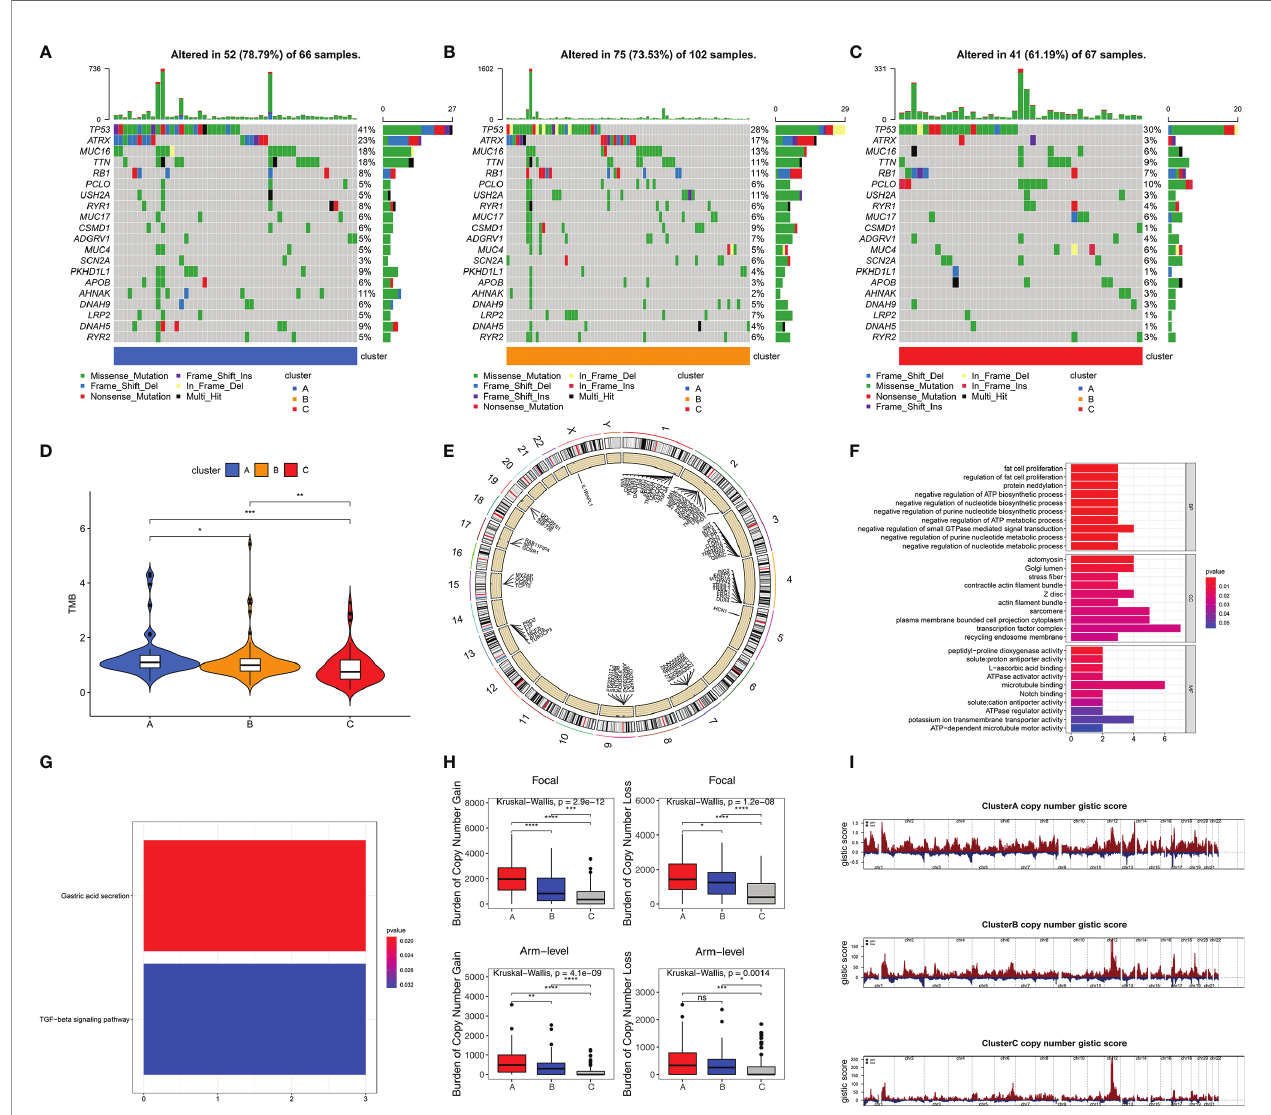
FIGURE 4 | High stemness was associated with more somatic mutation and CNA. Visualization of gene mutations in cluster A (A) , cluster B (B) , and cluster C (C) . (D) The difference of TMB in three stemness subtypes. TMB value was subjected to the transformation of log2(X+1). (E) The visualization of genes with signi fi cant CNAs associated with stemness in highest stemness (cluster A) and lowest stemness (cluster C). GO (F) and KEGG (G) analyses of genes with signi fi cant CNAs associated with stemness. (H) The differences of burden of copy number gain and loss among three stemness subtypes. (I) The visualization of copy number gistic scores among three stemness subtypes. ****p < 0.0001; ***p < 0.001; **0.001 < p < 0.01; *0.01 < p < 0.05; ns (not signi fi cant), p >